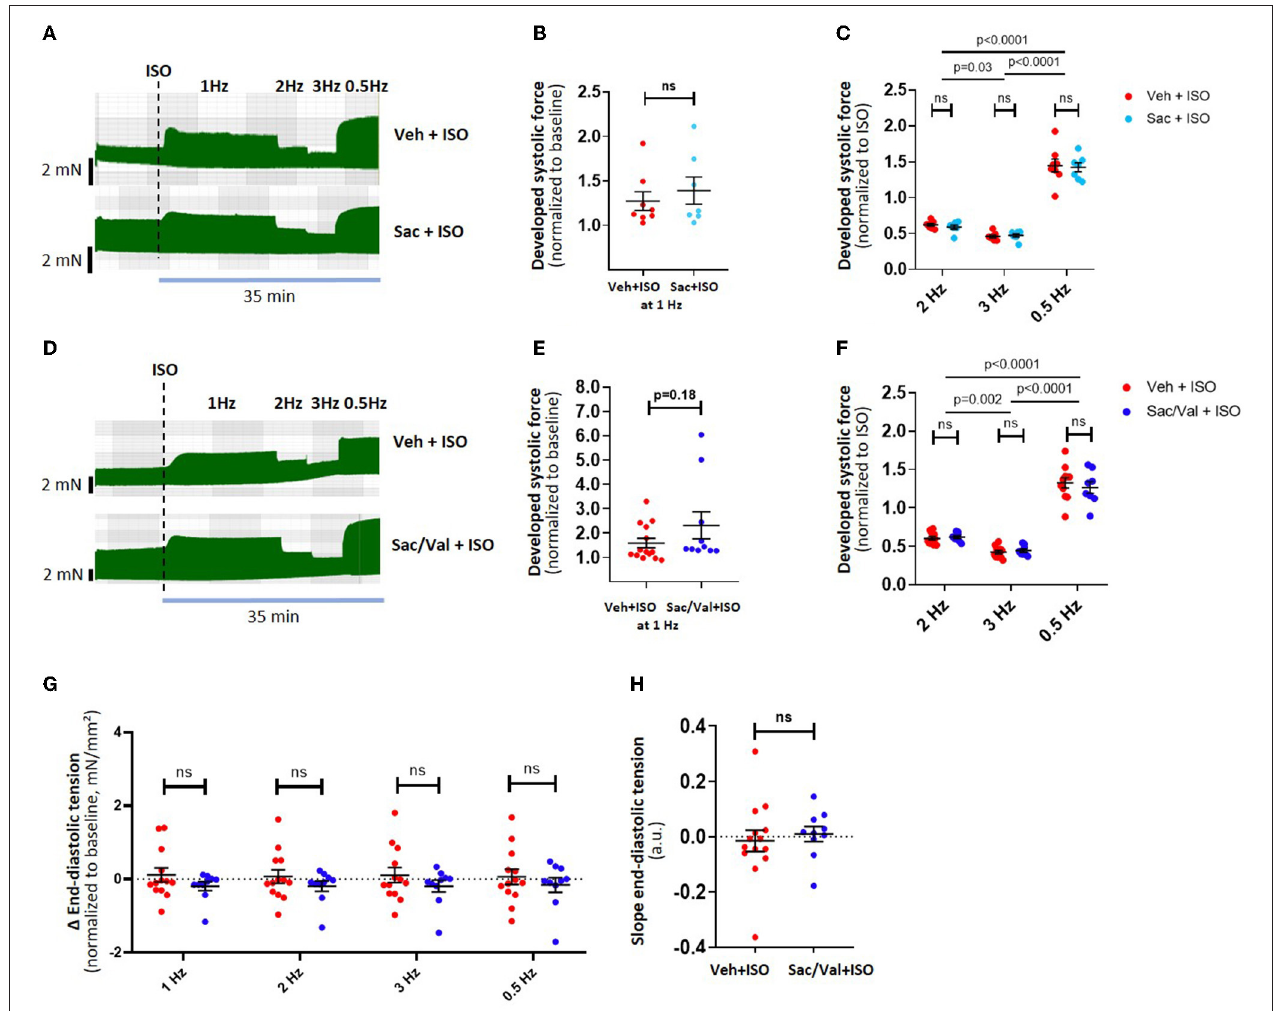
FIGURE 2 | Effect of Sac/Val on atrial inotropy and lusitropy after adrenergic stimulation. Example traces of a “frequency-variation protocol” in Sac-treated muscle strips ( n = 15 strips) are shown in (A) , with its effects on developed force during different frequencies shown in (B,C) . Examples traces of a frequency-variation protocol in Sac/Val treated muscle strips ( n = 24 strips) are shown in (D) , with the corresponding effects on developed force in (E,F) . The effects of Sac/Val on end-diastolic tension are shown as per stimulation frequency (G) and as the diastolic tension slope derived from linear regression (H) . Data are shown as mean ± SEM; each data point represents one muscle strip. ISO, isoproterenol, Sac: Sacubitrilat; Val: valsartan; Veh: vehicle